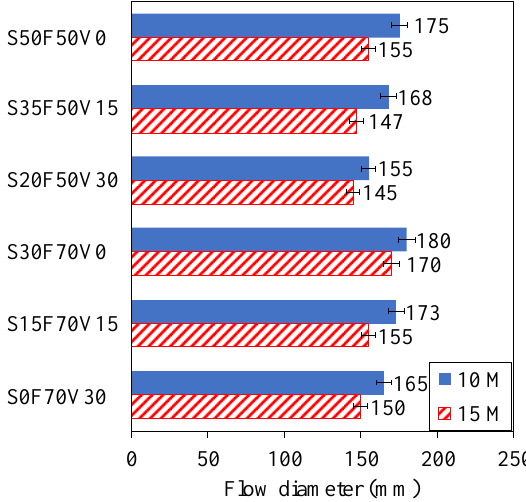
Figure 4. Flowability of geopolymer mortar.